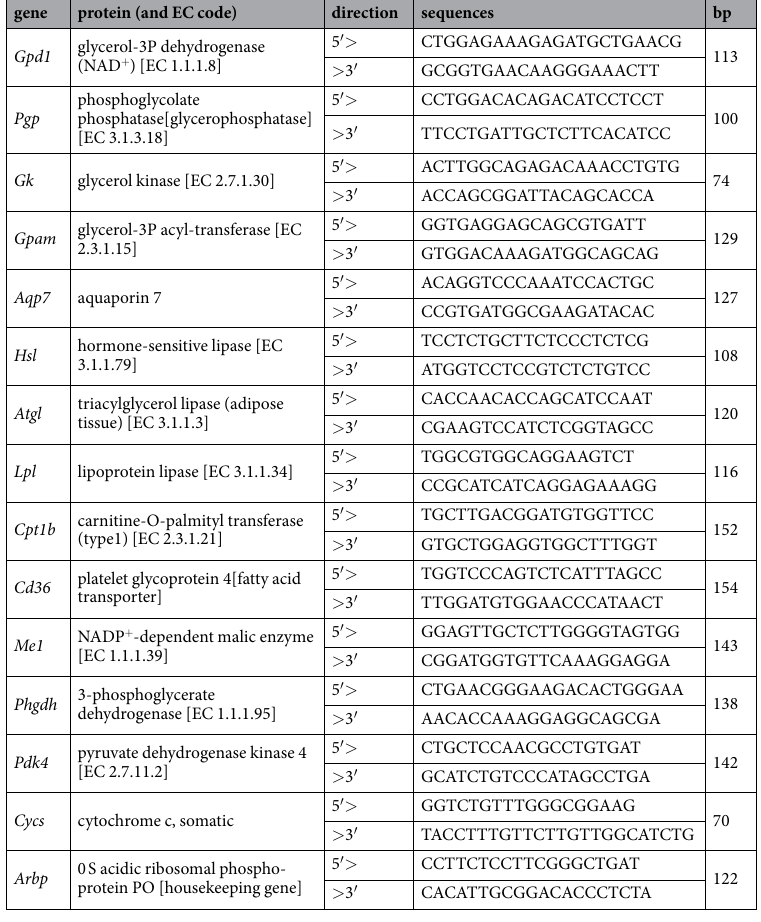
Table 3. Primers used for the analysis of gene expression. E.C. = Enzyme Code